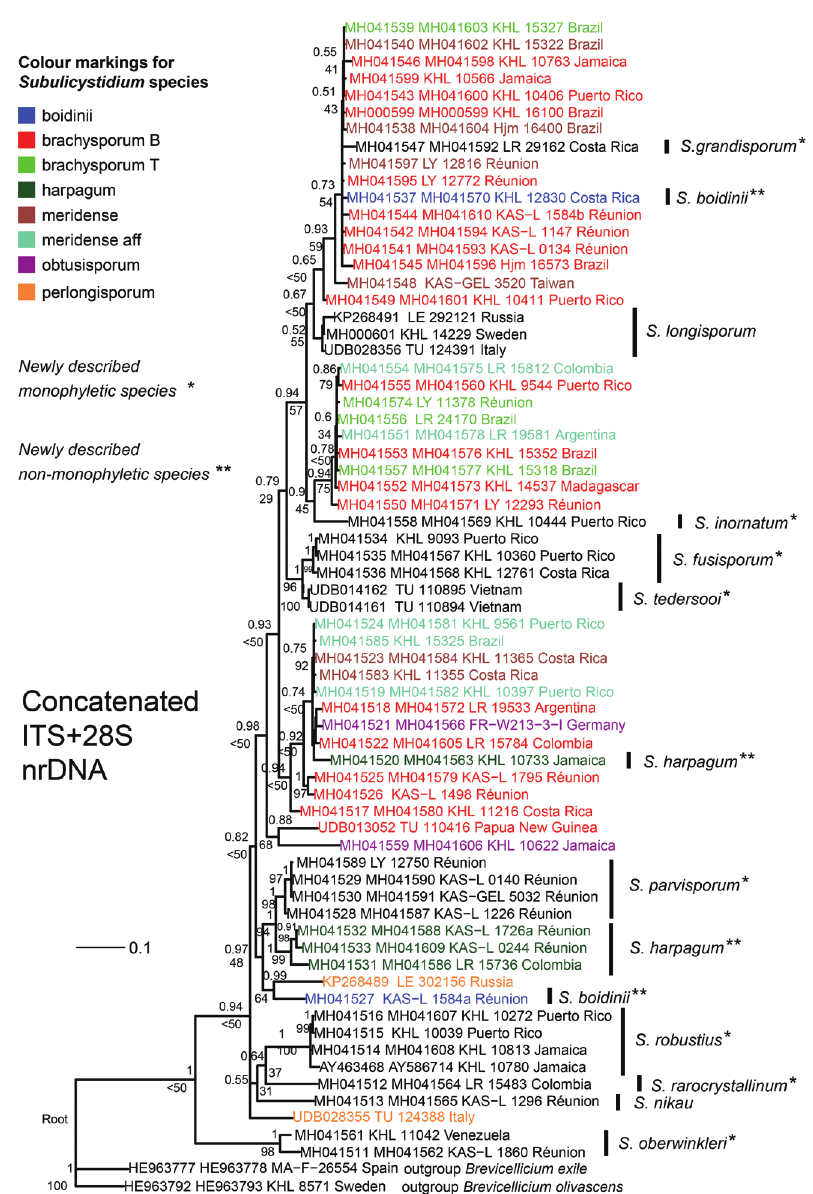
Figure 14. Phylogenetic relationship of Subulicystidium based on concatenated ITS+28S nrDNA align- ment. 50% majority-rule consensus tree from Bayesian analysis is shown, with posterior probabilities above the branches and bootstrap support values from the maximum likelihood estimation below the branches. Tips of the tree include GenBank/UNITE accession numbers of ITS followed by 28S region. Tips are an- notated according to morphological identification and marked with colours in non-monophyletic taxa (see legend). In the legend, the capital “B” following epithet in S. brachysporum means morphological species concept following Boidin and Gilles (1988), while “T” means the species as described by Talbot